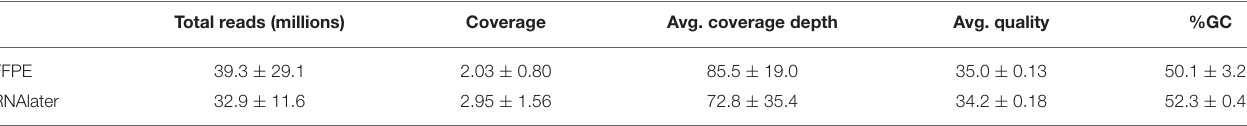
TABLE 1 | FastQC analysis results for FFPE and RNAlater sample types support comparable coverage and quality. Total reads